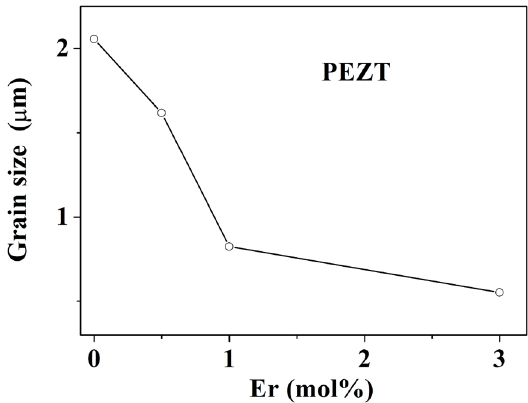
Figure 1. Average grain size (from SEM) in PZT52/48 and PEZT ceramics samples with varying Er content in the